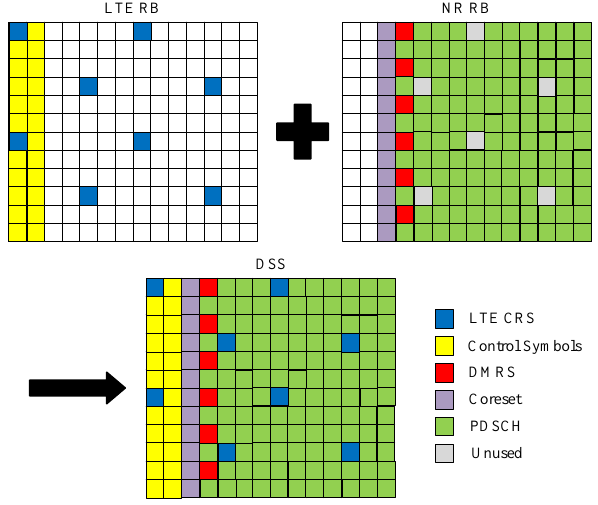
Figure 9. Schematic diagram of rate